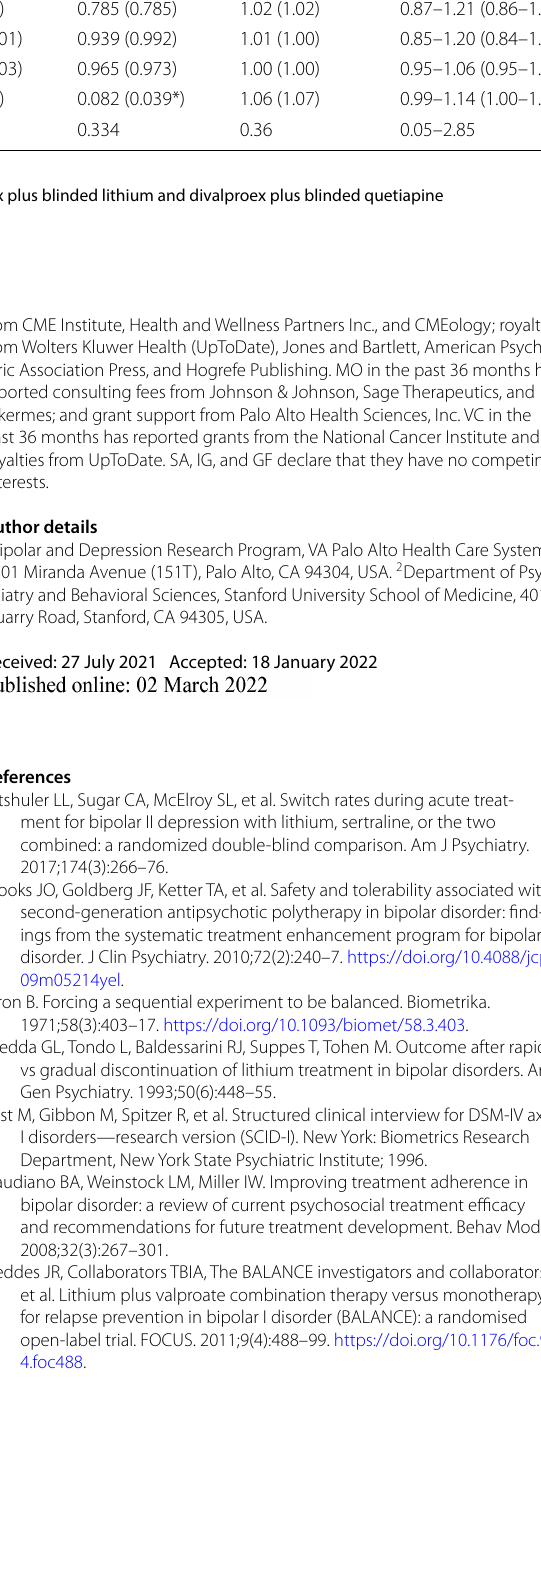
Table 7 Cox regression on retention for monotherapy versus aggregated combination therapies